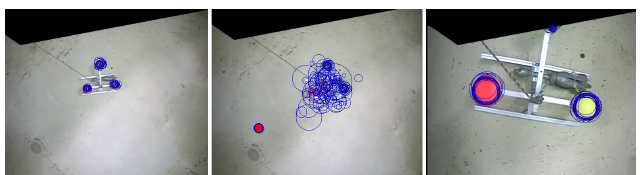
Figure 22. Testing the filter: in this figure, we can observe three images: the left one is an image of the target placed on the bottom of the tank, the tracking algorithm is running with a particle filter per each marker; the middle one is an image of the target placed on the bottom of the tank with an outlier (red point) located on the left hand; the image on the right is an image of the target placed on the bottom of the tank with an occlusion of the green marker